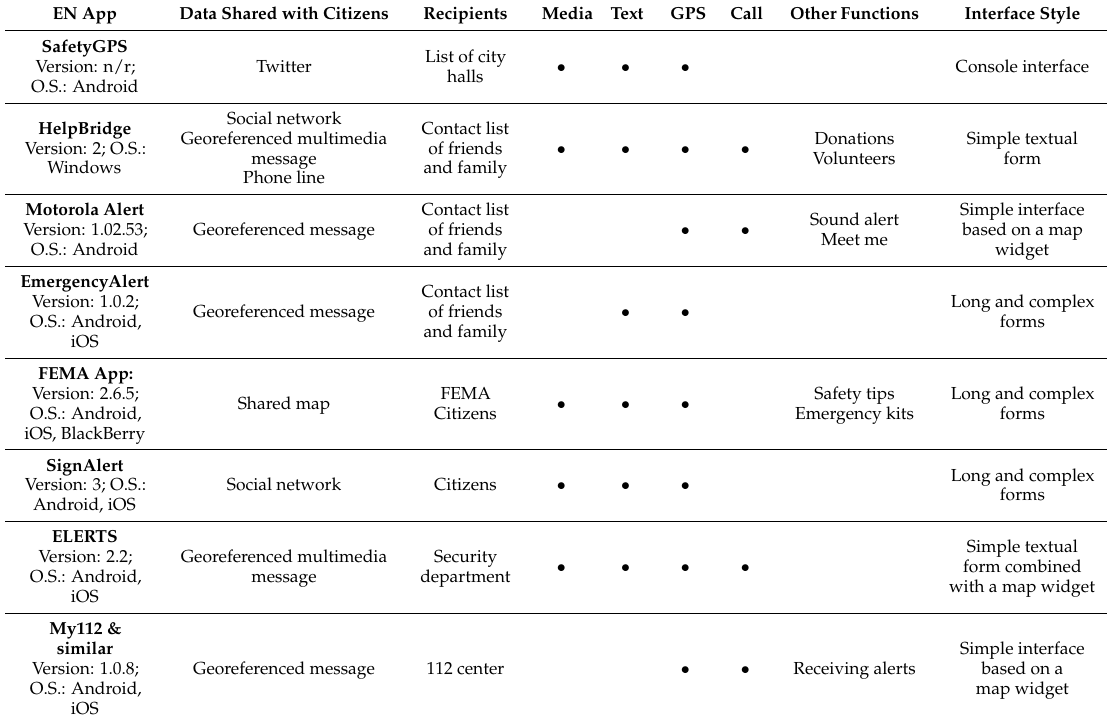
Table 1. Analyzed mobile applications with their main